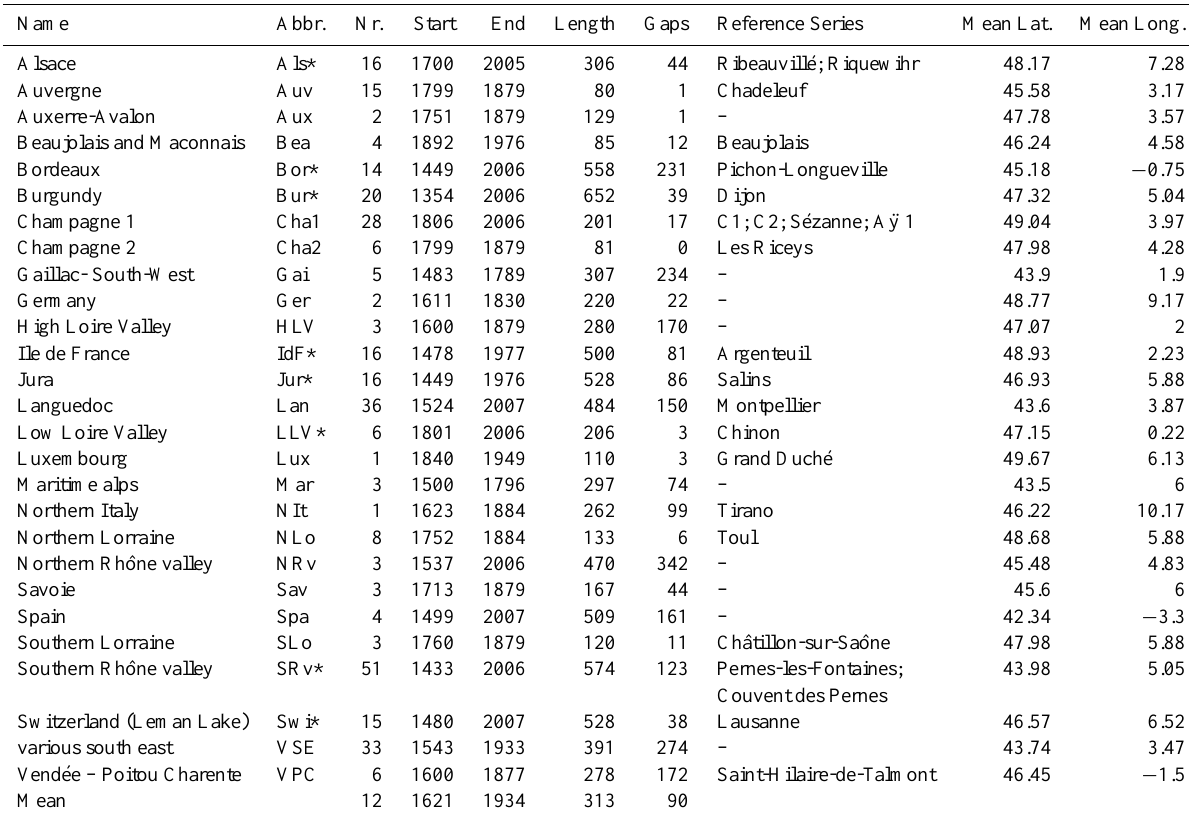
Table 1. Description of the regional composite series of grape harvest dates. Abbr.: abbreviation; Nr.: Number of series included in the composite series. *: series in which quality was analysed more